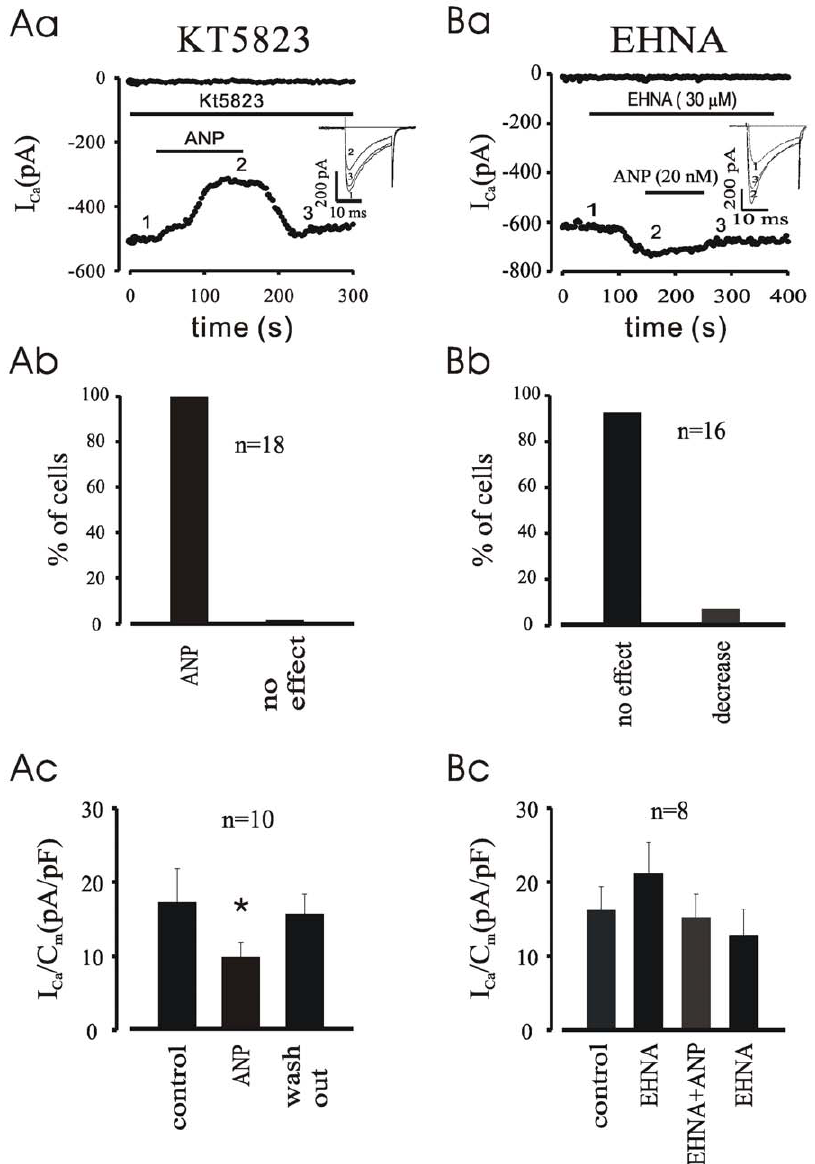
Figure 7. PDE2-cAMP-PKA pathway of ANP depression on I CaL . A , time course of I CaL (a) shows ANP still inhibits the current in KT5823, a PKG selective inhibitor, pre-treated myocytes in about 70% cells tested (b); Ac , density of peak I CaL. B , time course (a) demonstrates that ANP fails to depress I CaL in the presence of EHNA, a PDE2 selective inhibitor, in almost all cells tested (b). Bc , density of peak I CaL. *P , 0.05 compared with control.